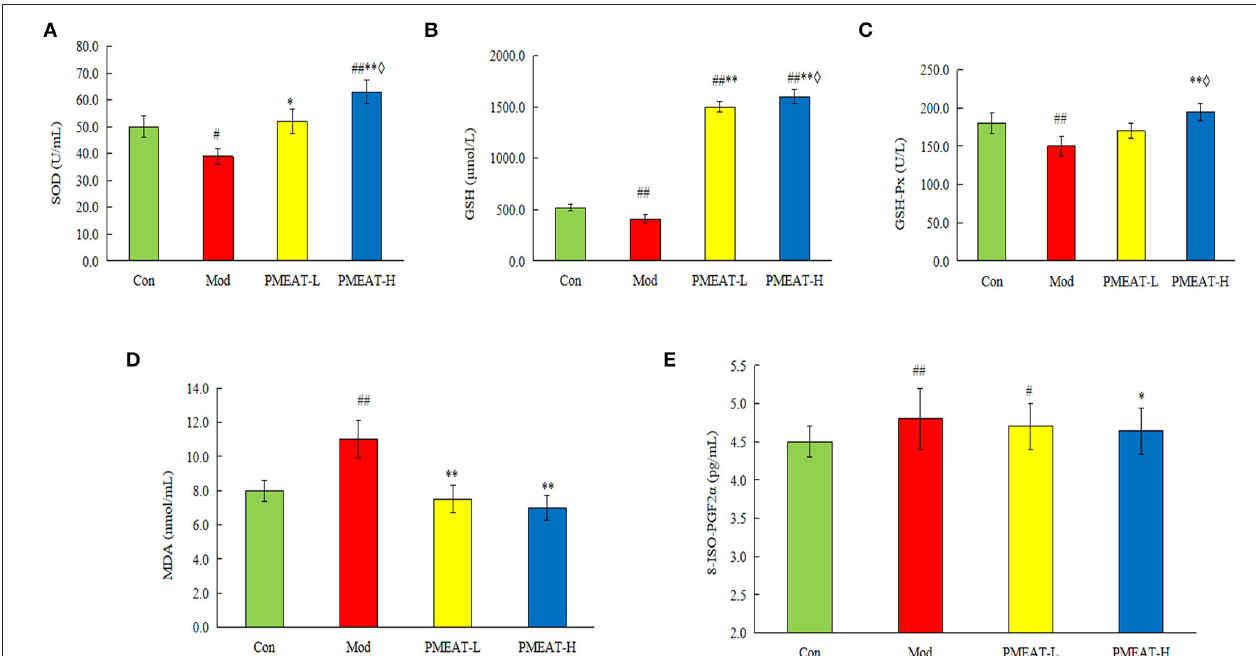
FIGURE 5 | Effect of PMEAT treatment on plasma SOD, GSH, GSH-Px, MDA, and 8-ISO-PGF2 α . (A) Plasma SOD of four observed groups. (B) Plasma GSH of four observed groups. (C) Plasma GSH-Px of four observed groups. (D) Plasma MDA of four observed groups. (E) Plasma 8-ISO-PGF2 α of four observed groups. One-way ANOVA was applied to examine the differences among the three groups. Superscript # and ## indicate statistically significant differences compared with the Con group ( p < 0.05) and ( p < 0.01), respectively. Superscript * and ** indicate statistically significant differences compared with the Mod group ( p < 0.05) and ( p < 0.01), respectively. Superscript ♦ indicates a statistically significant difference compared with the PMEAT-L group ( p < 0.05). Con, control group; Mod, model group; PMEAT-L, low-dose PMEAT group; PMEAT-H, high-dose PMEAT